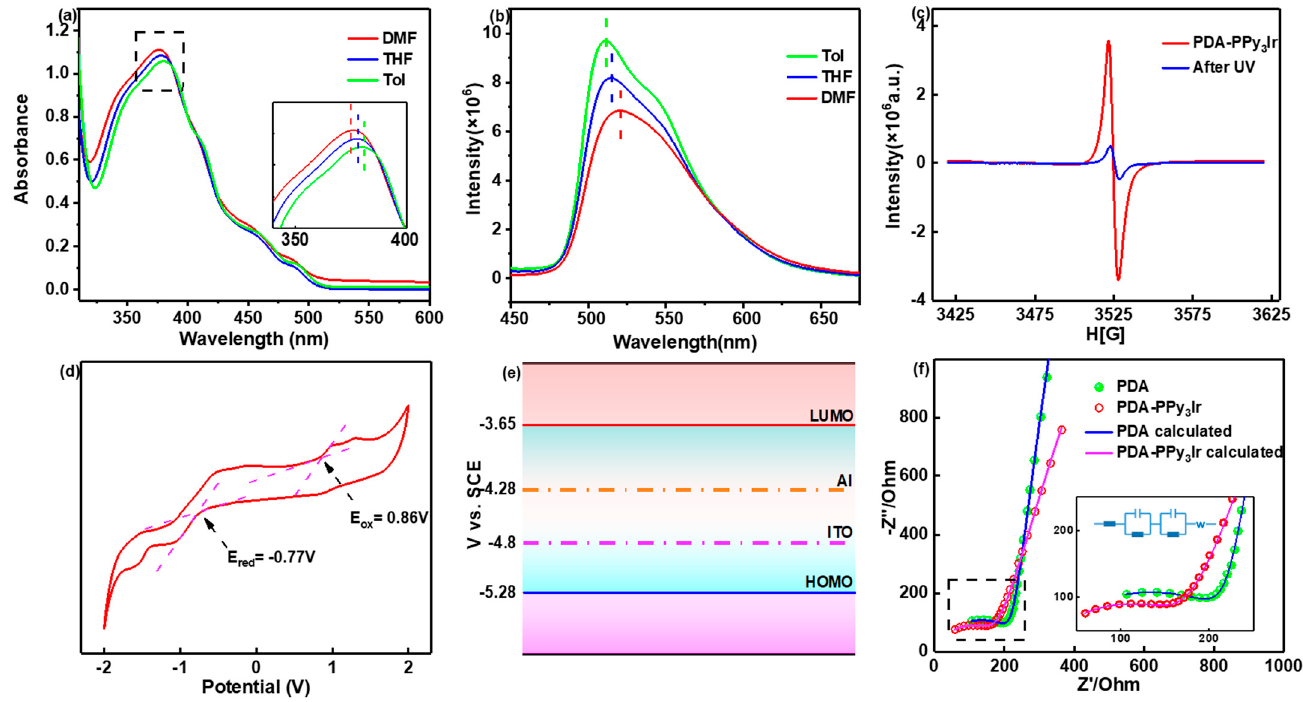
Figure 5. ( a ) UV-vis spectra and ( b ) FL spectra of PDA-PPy 3 Ir in different solvents; ( c ) EPR spectra of PDA-PPy3Ir before and after UV light illumination; ( d ) cyclic voltammetry curve and ( e ) band structure of PDA-PPy3Ir; ( f ) AC impedance spectra and the equivalent circuit diagram.